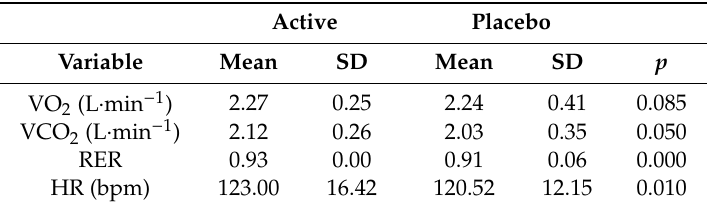
Table 5. Submaximal test metabolic